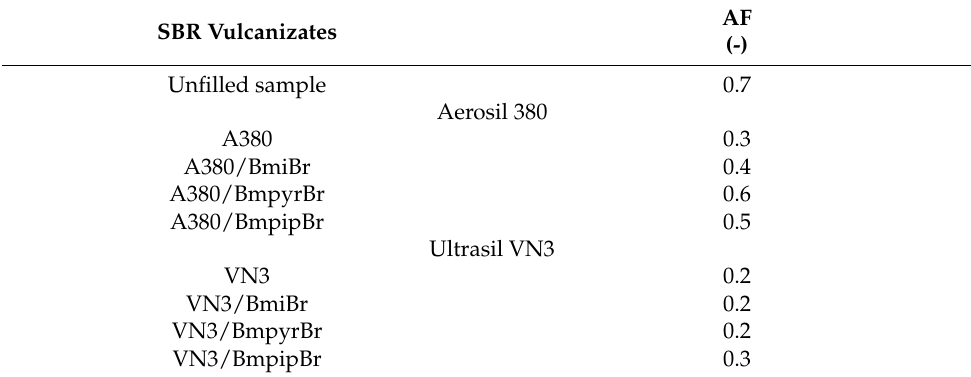
Table 7. Thermo-oxidative aging coefficient (AF) of SBR vulcanizates filled with silica A380 and VN3 (SD: AF ±